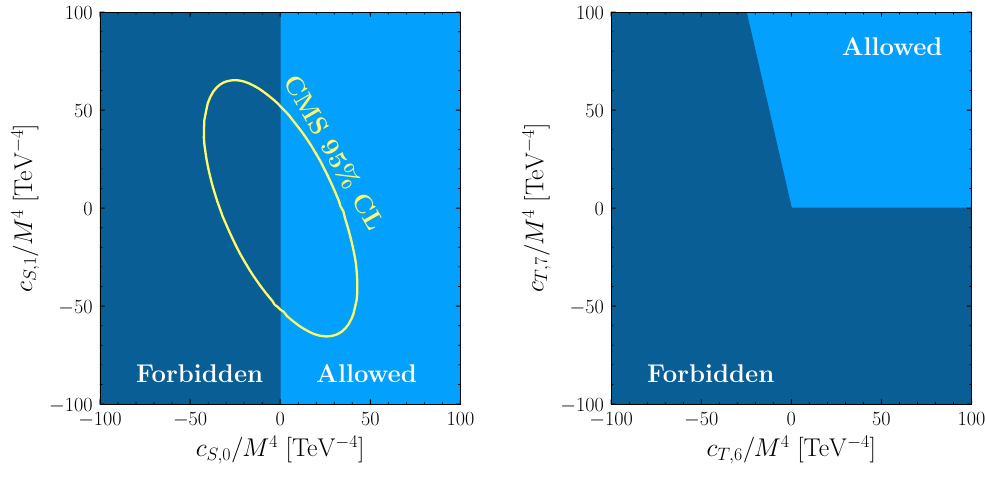
Figure 10 . Two examples of the allowed and forbidden aQGC parameter space, as demarcated by our bounds. In each (cid:12)gure we have marginalized over the operators that are not shown. On the left we show the allowed parameter space in the c S; 0 and c S; 1 plane, applying the bounds in eq. (6.2). Note that c S; 0 + c S; 1 + c S; 2 > 0 provides no additional information in this plane